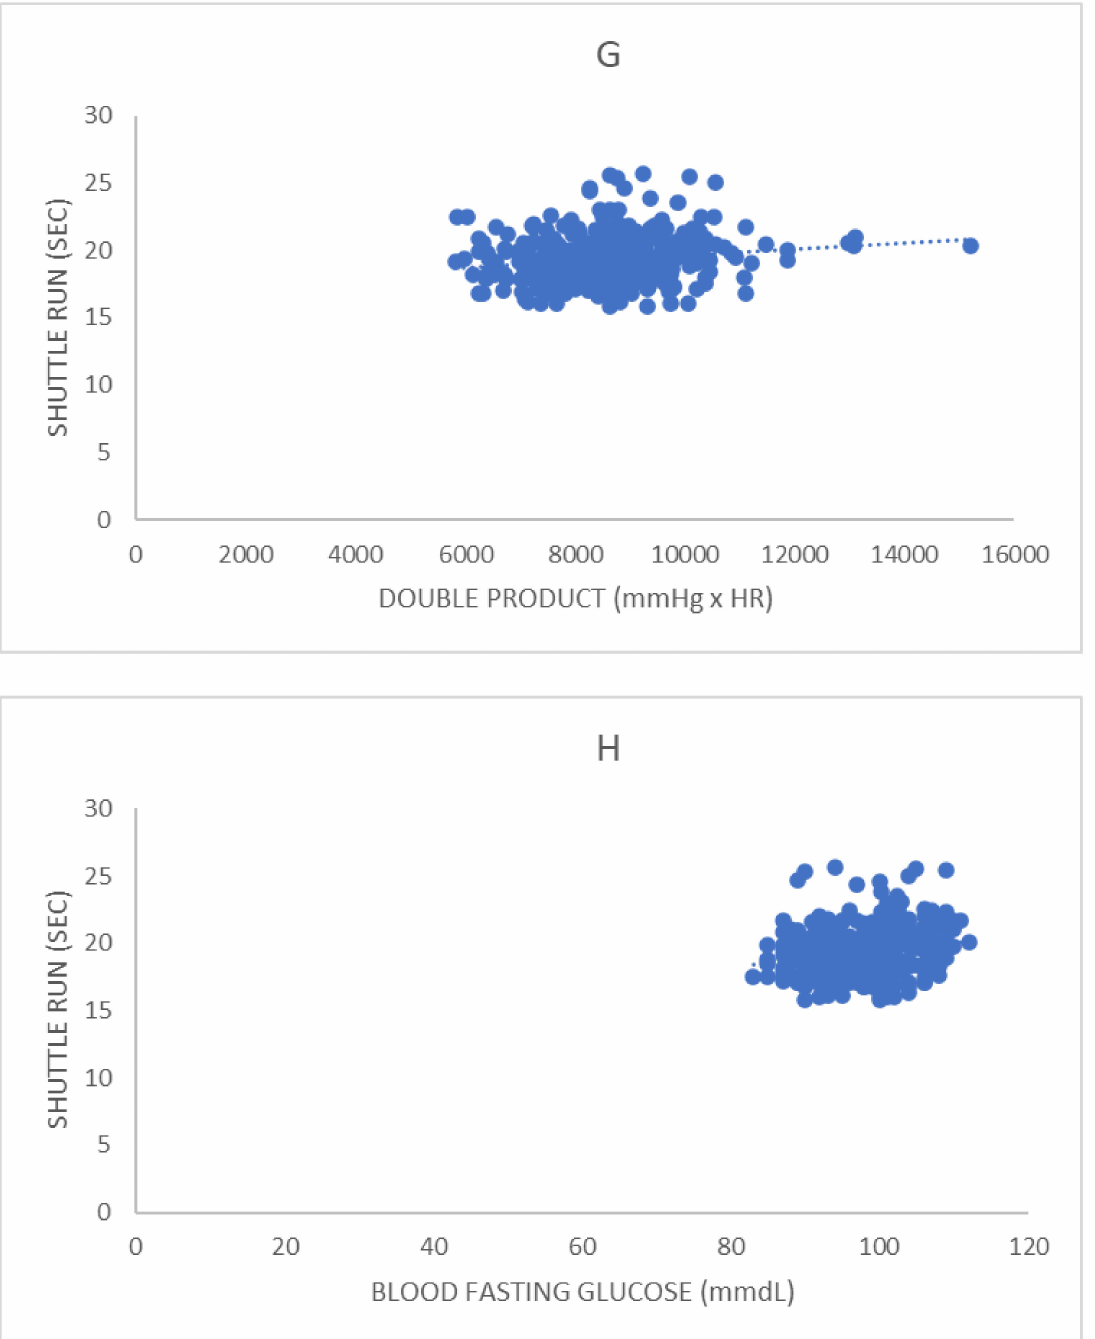
Figure 3. Correlation between the results obtained by the study participants in the shuttle run test and the anthropometric and health variables with which it maintained a significant correlation: ( A ) weight; ( B ) height; ( C ) body mass index; ( D ) body fat percentage; ( E ) abdominal girth; ( F ) systolic blood pressure; ( G ) double product; ( H ) fasting blood